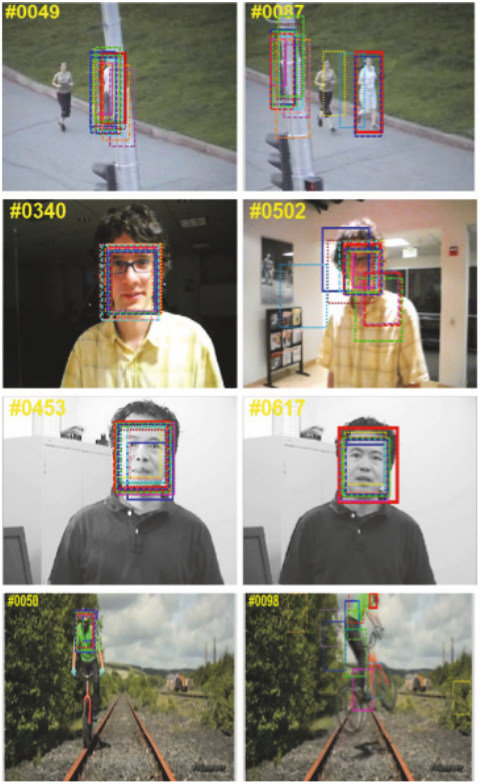
Figure 4: Examples of tracking results on representative frames of other four